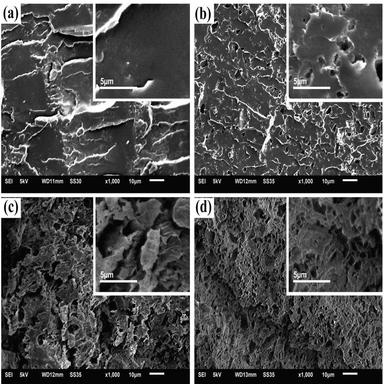
SEM micrographs of cryo-fractured surfaces for PVC films and PVC porous films: (a) 0 v%, (b) 10 v%, (c) 20 v%, (d) 50 v%.